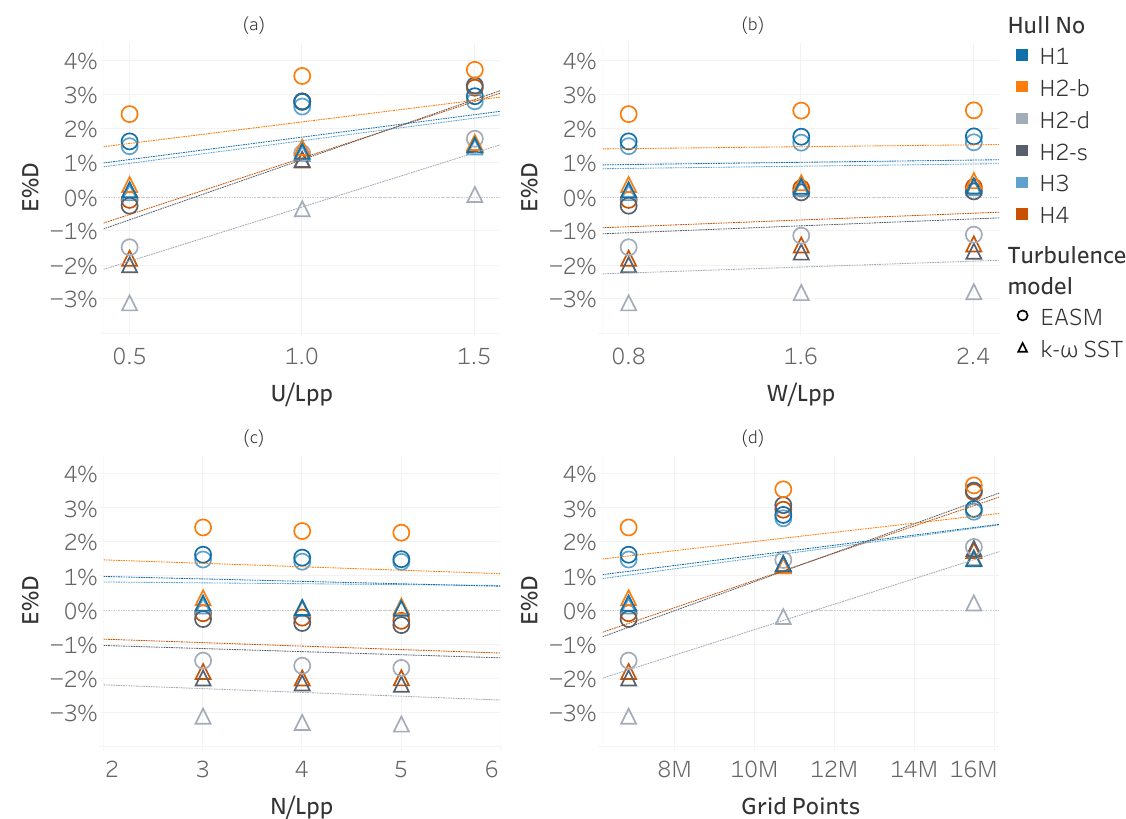
Figure 7. Comparison error of all test cases for the domain size variations: ( a ) U/L PP , ( b ) W/L PP , ( c ) N/L PP , ( d ) in all